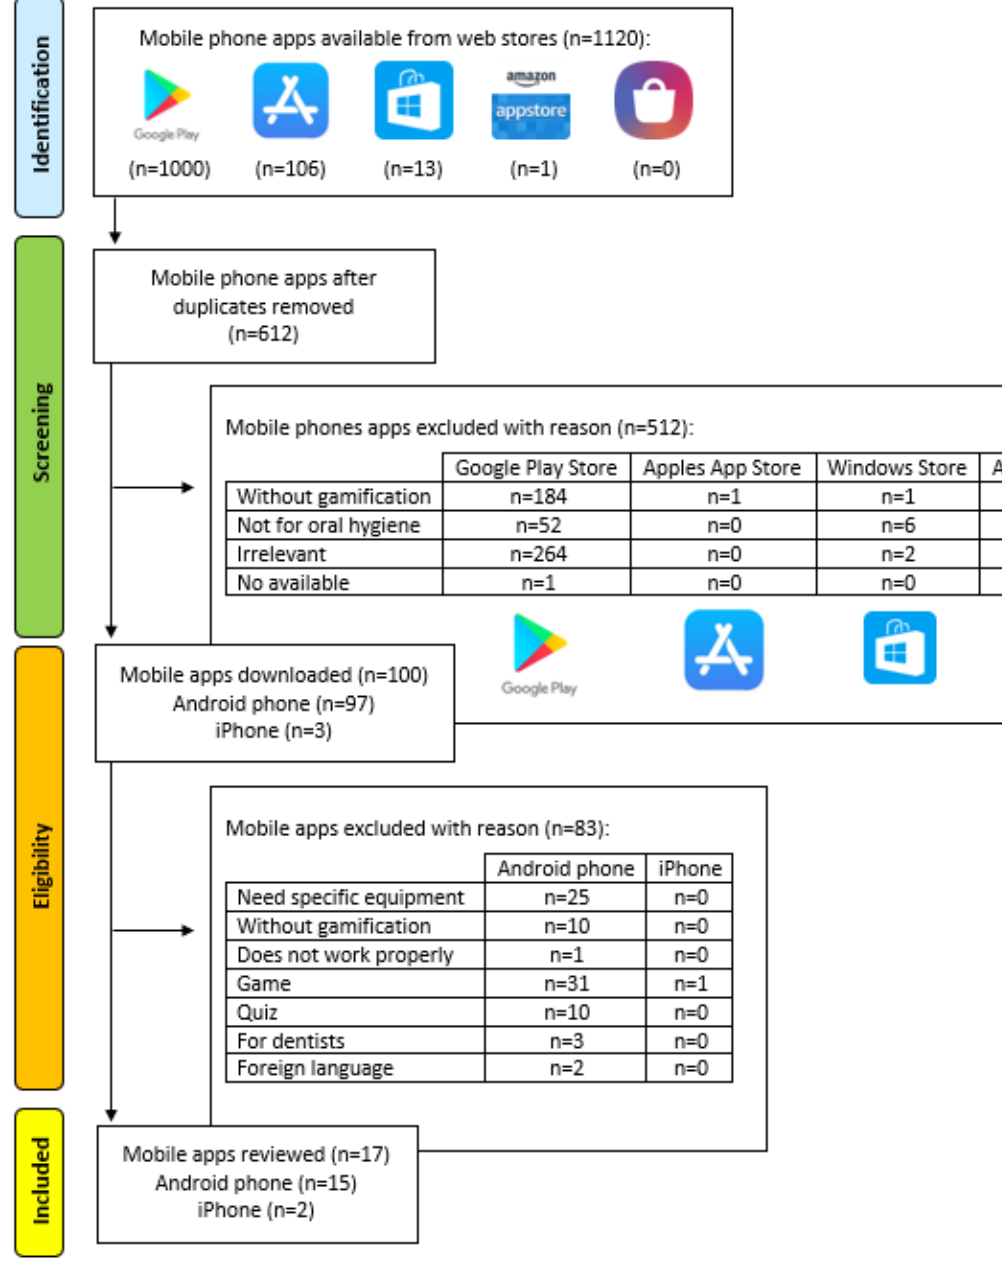
Figure 1. PRISMA flow diagram of the selection of the included